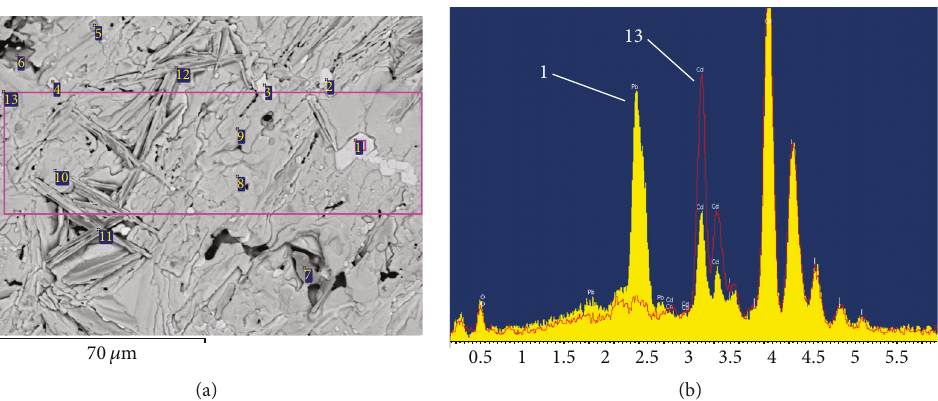
Figure 2: SEM images (a) and EDS spectrum (b) of PbCdI 2 thick film obtained in phase-contrast mode using a Zeiss EVO 50 XVP scanning electron microscope. Spots 1–13 in SEM images indicate the areas of the film surface where its chemical composition has been determined. EDS spectra correspond to 1 and 13 spots, respectively.